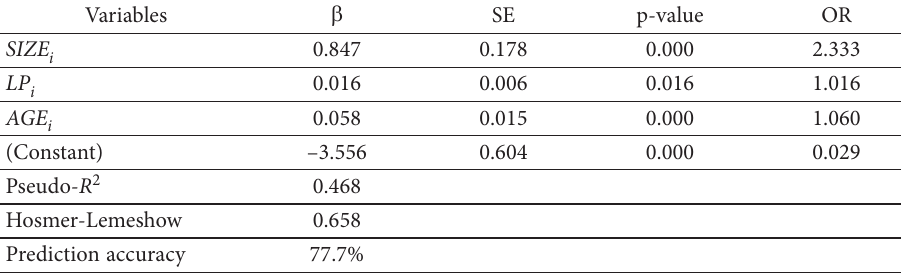
Table 6. Prediction of export orientation with the firm’s structural variables Variables β